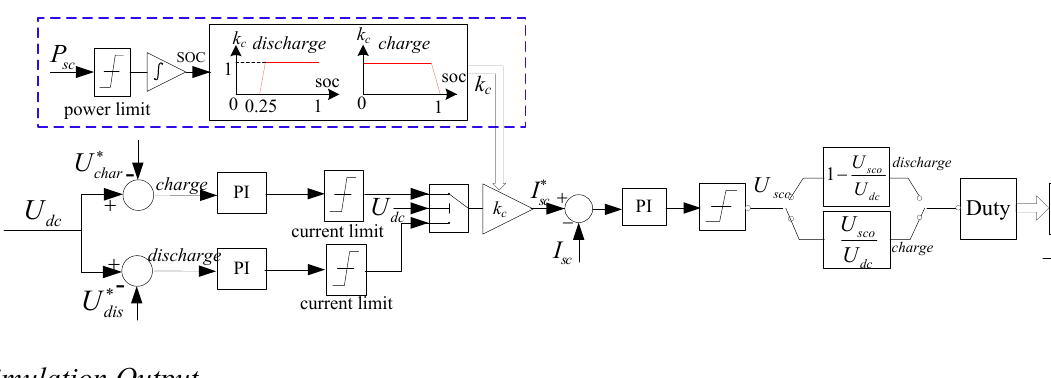
Figure 8. Stationary ESS energy control strategy.